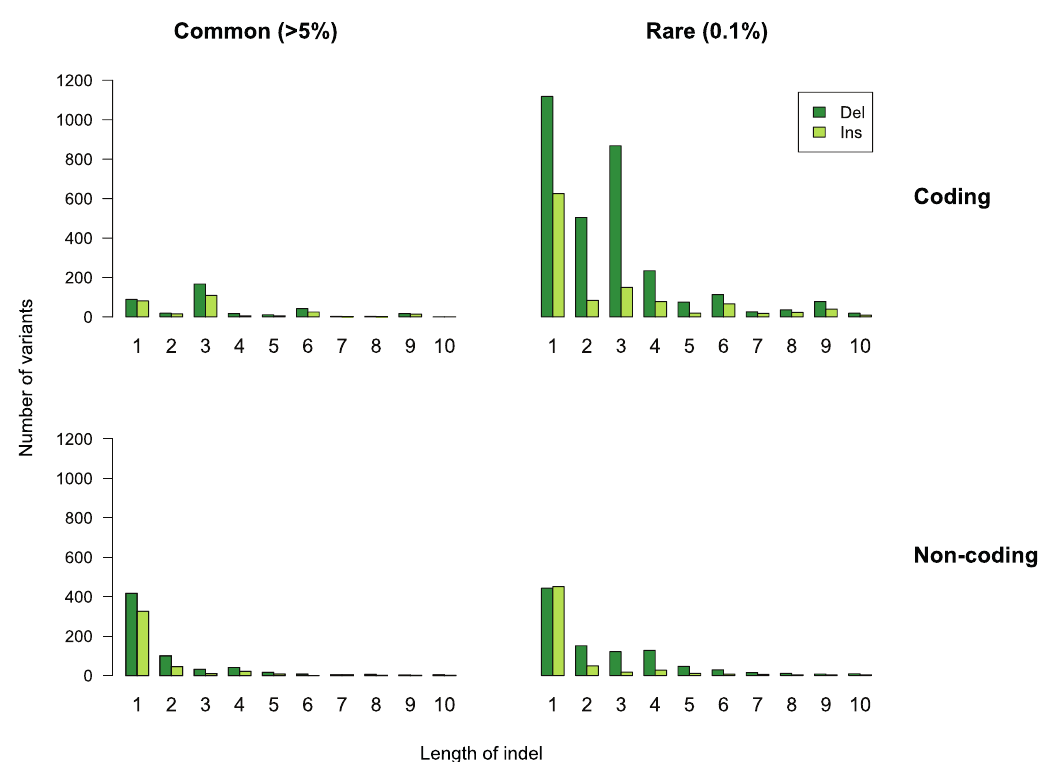
Figure 4. Summary of indel characteristics in the ICR1000 UK exome series. Variant frequency varies with type and length of indel. Deletions are more common than insertions, particularly for rare variants. There is enrichment of indels of 3 bp, 6 bp and 9 bp in coding but not non-coding sequence, because these cause inframe variants.